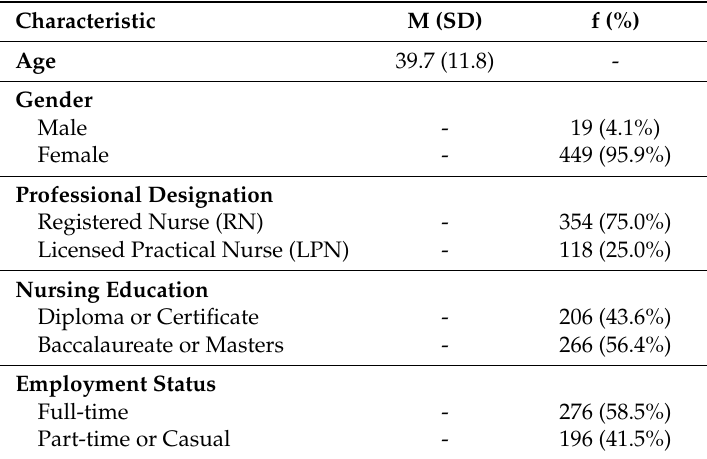
Table 1. Descriptive statistics of sample ( N = 472).